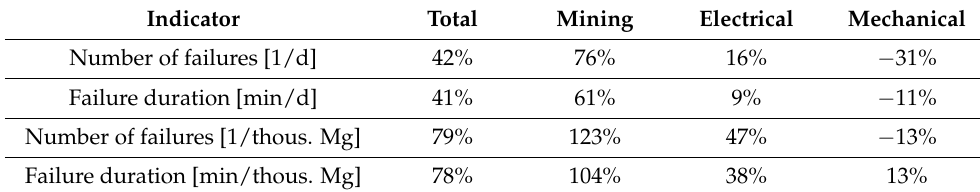
Table 3. Percentage of failures in plow longwalls in relation to shearer longwalls. Indicator Total Mining Electrical Mechanical Number of failures [1/d] Number of failures [1/thous. Mg]